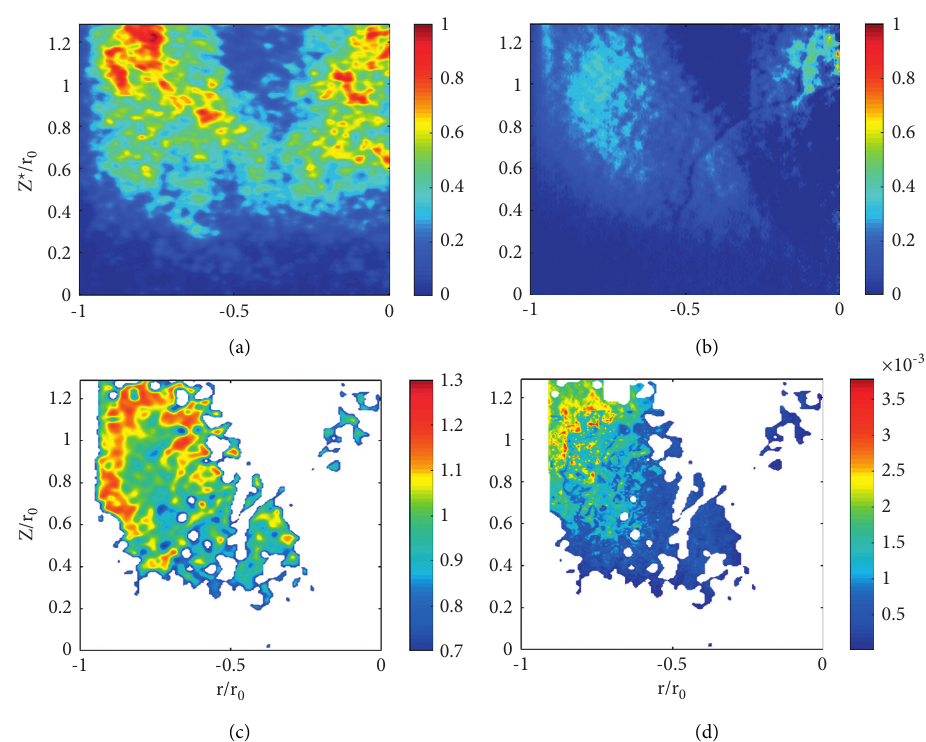
Figure 16: Intermediate heat release processing for 36 deg no PIM results. Instantaneous OH ∗ chemiluminescence (a), phase averaged Abel inverted OH ∗ intensity (b), equivalence ratio (c), and heat release (d) (Watts/m 3